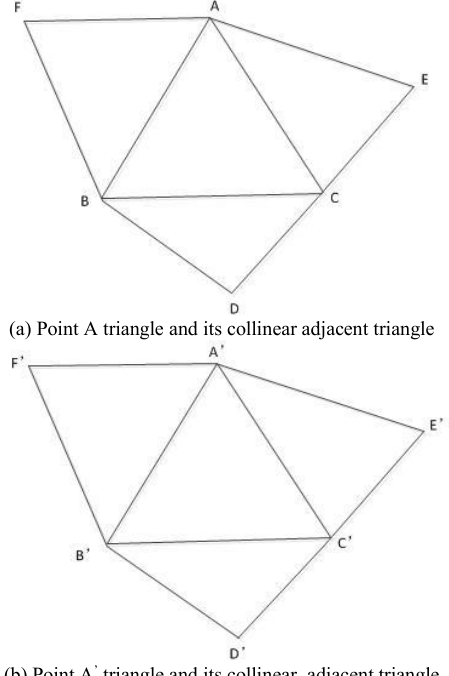
Fig. 4. The triangle and the collinear adjacent triangle